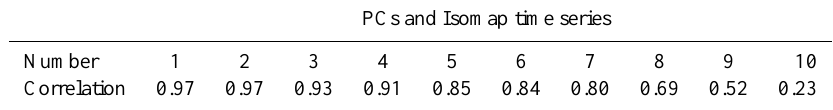
Table 1. Correlation coefficients between the leading 10 PCs and the Isomap time series of the SLP anomalies. PCs and Isomap time